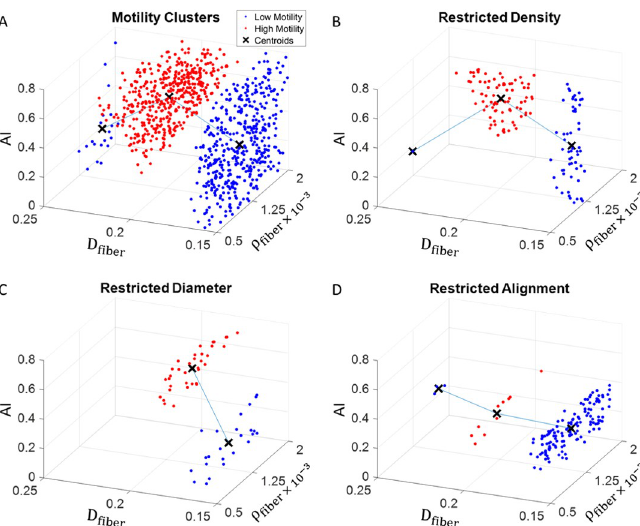
Fig 7. Cluster classification of high and low states of diffusion. Red spheres represent top 85% and bottom 15% of diffusivity. A) diffusivity clusters over entire range of fiber alignment, fiber density, and fiber alignment B) diffusivity clusters with restricted fiber density C) diffusivity clusters with restricted fiber diameter D) diffusivity clusters with restricted fiber alignment. Each point is the average of 10 separate